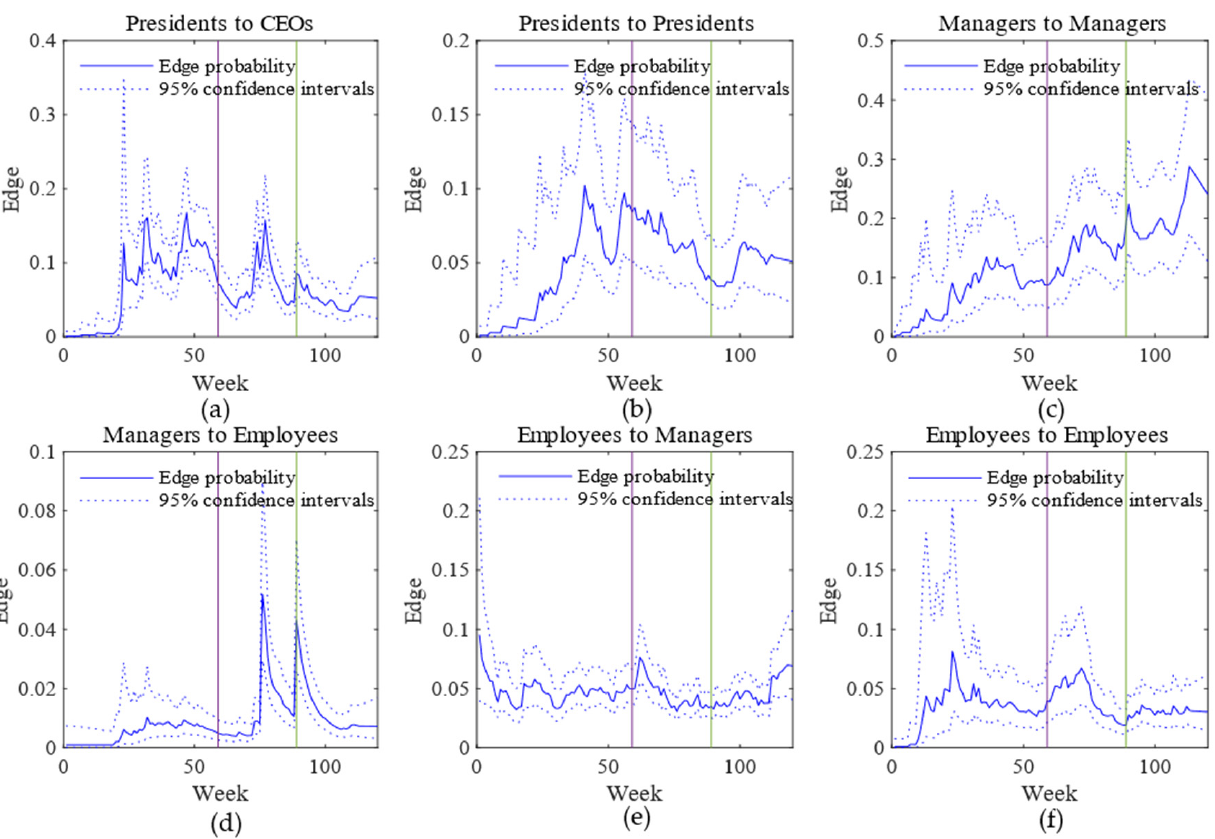
Figure 9. Probability of edges between communities on the Enron mail. ( a – f ) are the edge probabilities between different roles.